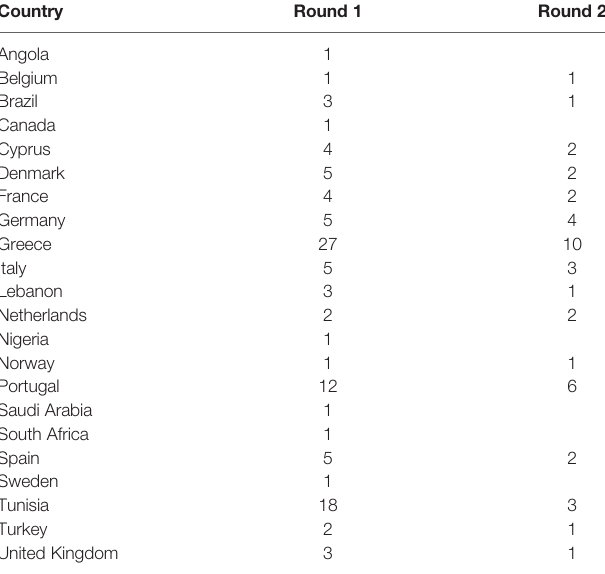
TABLE 2 | Number of responses by country in round 1 and round 2 of the survey. Country Round 1 Round